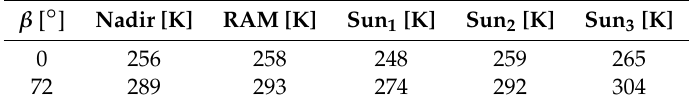
Table 2. Average temperature of the entire orbit for different attitudes and β . β [ ◦ ] Nadir